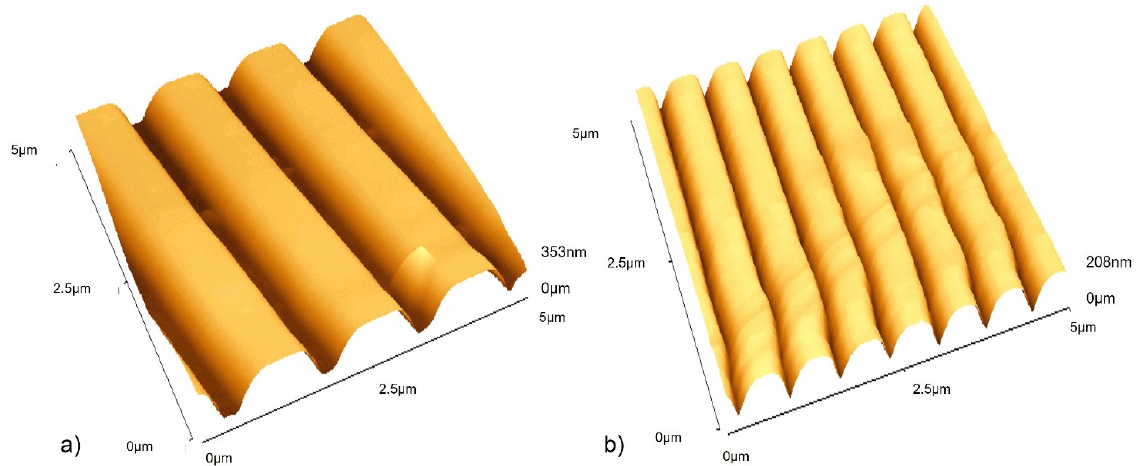
Figure 2. Scanning electron microscopy (SEM) images of ( A ) Ti-coated CD surface, ( B ) Ti-coated DVD surface, and ( C ) TiSi surface.